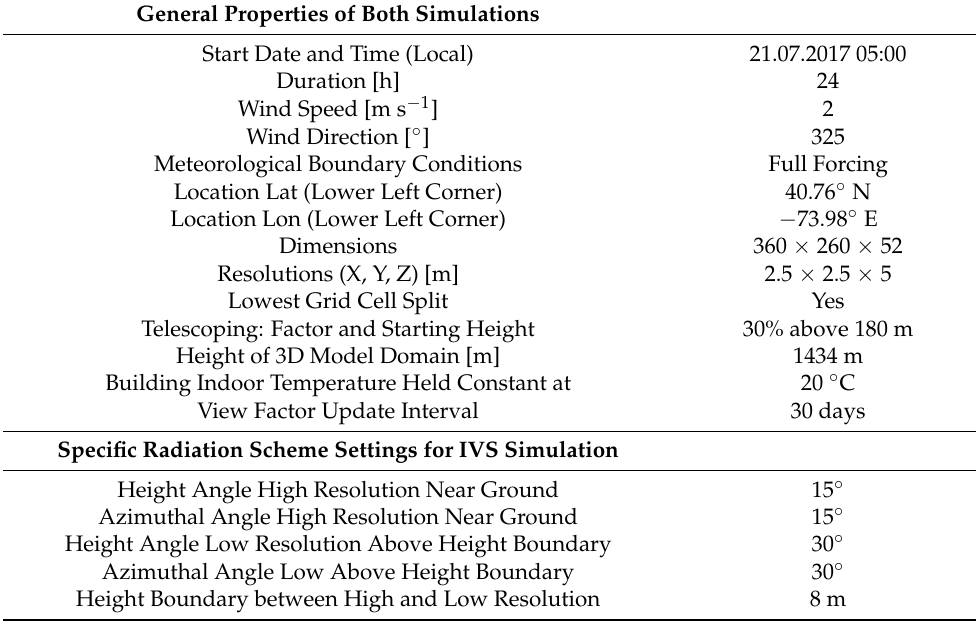
Table 2. Parameters of the proof-of-concept